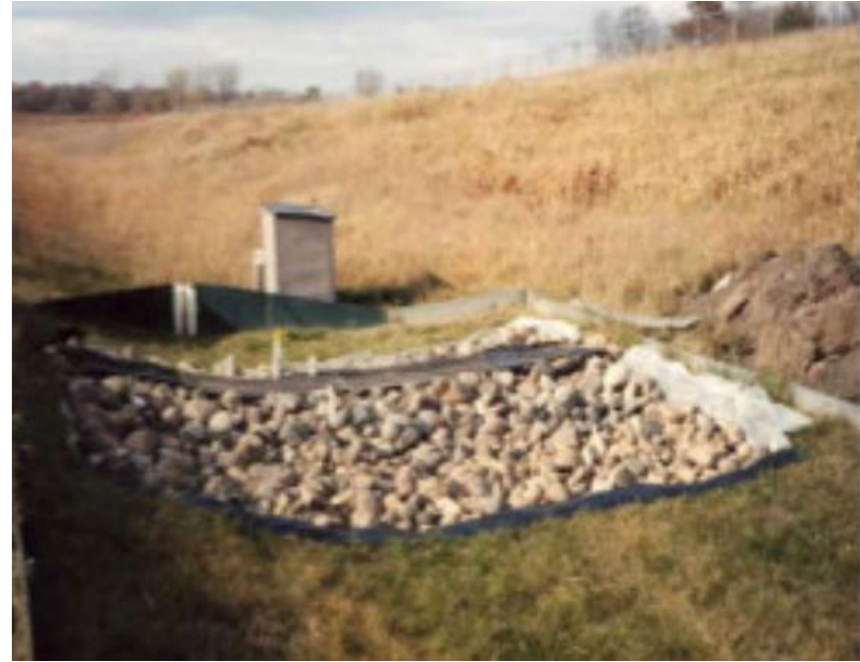
Figure 6. Pollution control research showing the check dam at MnROAD [5].